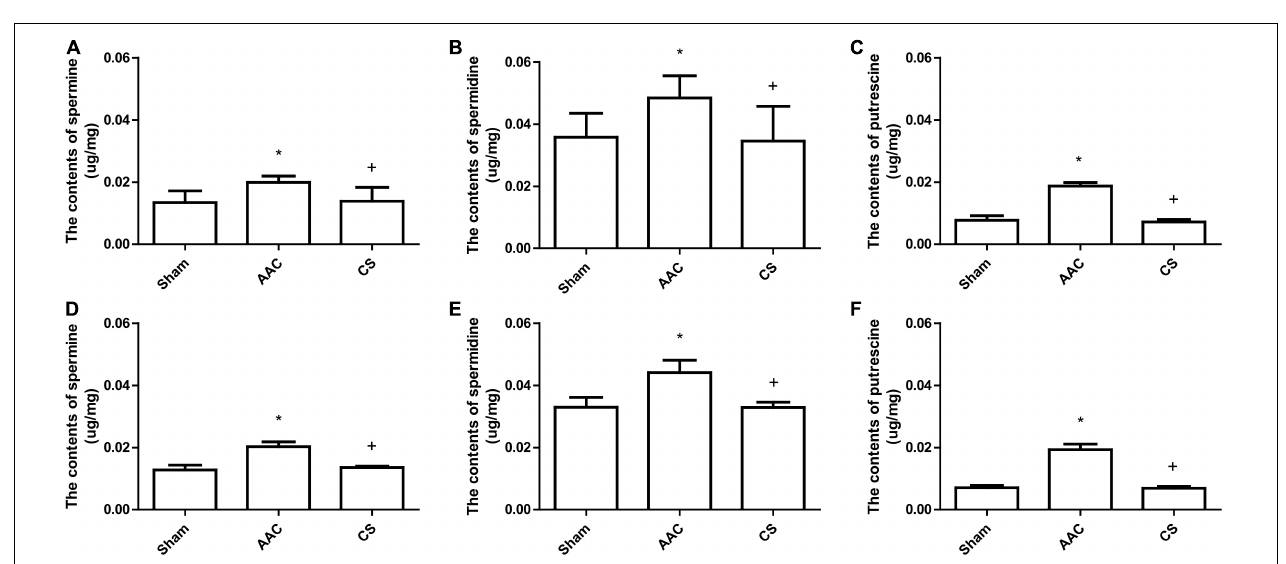
FIGURE 1 | Mast cell density changes in cardiac tissue. (A,B) Mast cell density 4 weeks (A) and 8 weeks (B) after abdominal aortic constriction; mast cells indicated by arrows stained dark purple with toluidine blue (400 × magnification). AAC, abdominal aortic constriction; CS, cromolyn sodium; n = 7 per group. * P < 0.05 vs sham group; + P < 0.05 vs AAC group; Scale bars, 100 µ m.